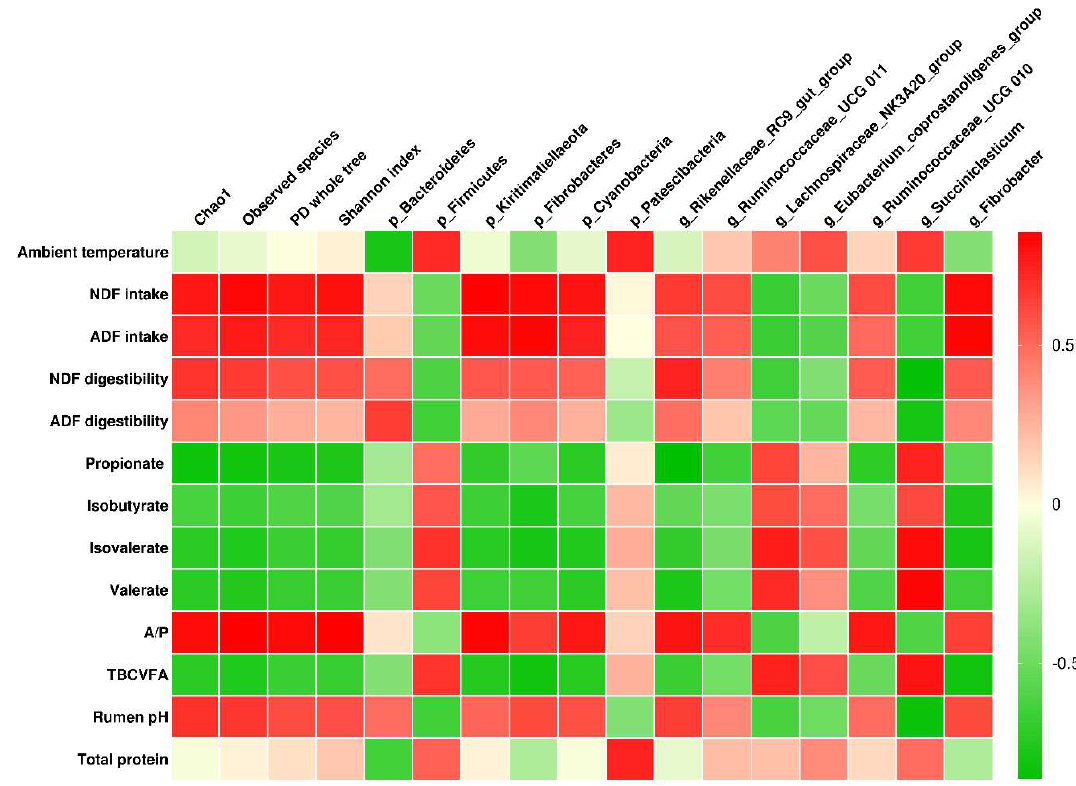
Figure 1. Correlations between ambient temperature, physiological and digestive characteristics, and bacterial abundances of Holstein finishing steers fed three nutrient density diets. Only significant correlations (r > 0.70 or r < − 0.70 and q-value < 0.05) and bacteria abundances greater than 0.5% are shown. The colors indicate positive (red, closer to 1) or negative (green, closer to − 1) correlations between investigated characteristics and bacterial abundances. A / P, acetate to propionate ratio; TBCVFA, total branched-chain volatile fatty acids.